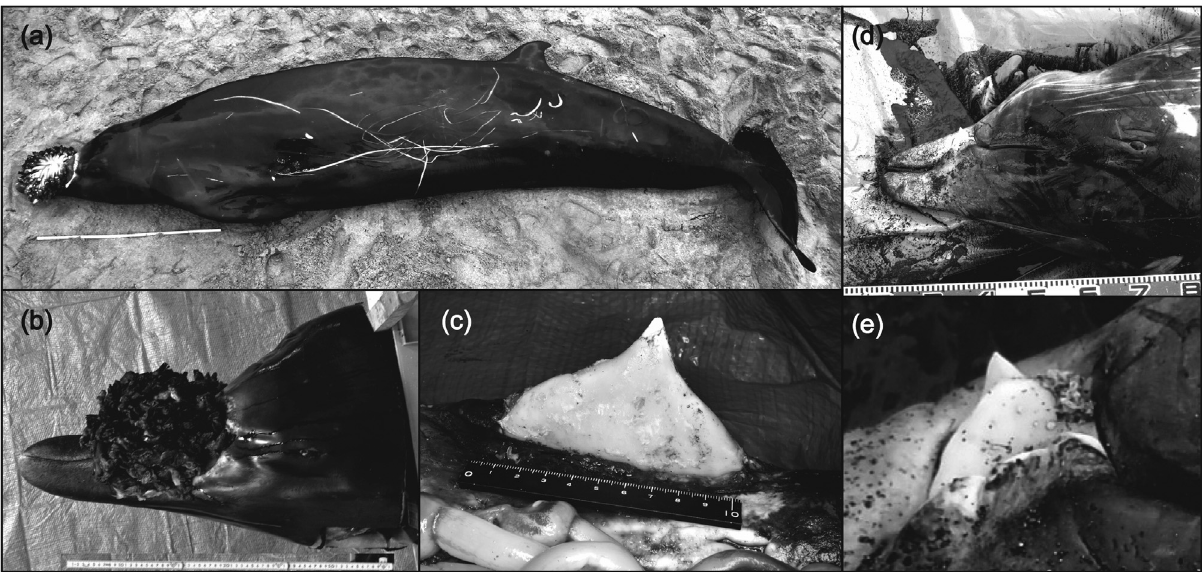
Figure1 -Externalmorphologyandtusksof Mesoplodonstejnegeri (a,b,andc)and M.carlhubbsi (dande).Thetusksof M.stejnegeri wereobservedaf- ter removing Conchoderma sp. from them